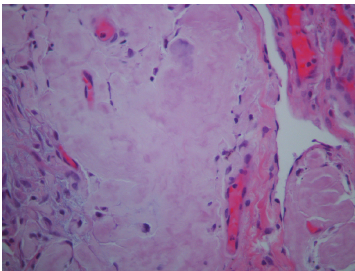
Figure 3: Intrapulmonary interstitial deposits of eosinophilic amorphous material that showed apple-green birefringence under polarized light on Congo Red stains (H&E, 400x).